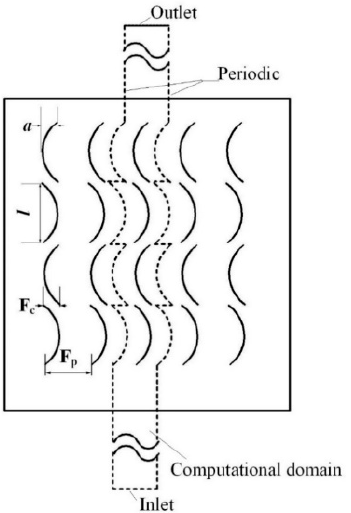
Figure 2. Computational domains and boundary details for the staggered wavy fin.